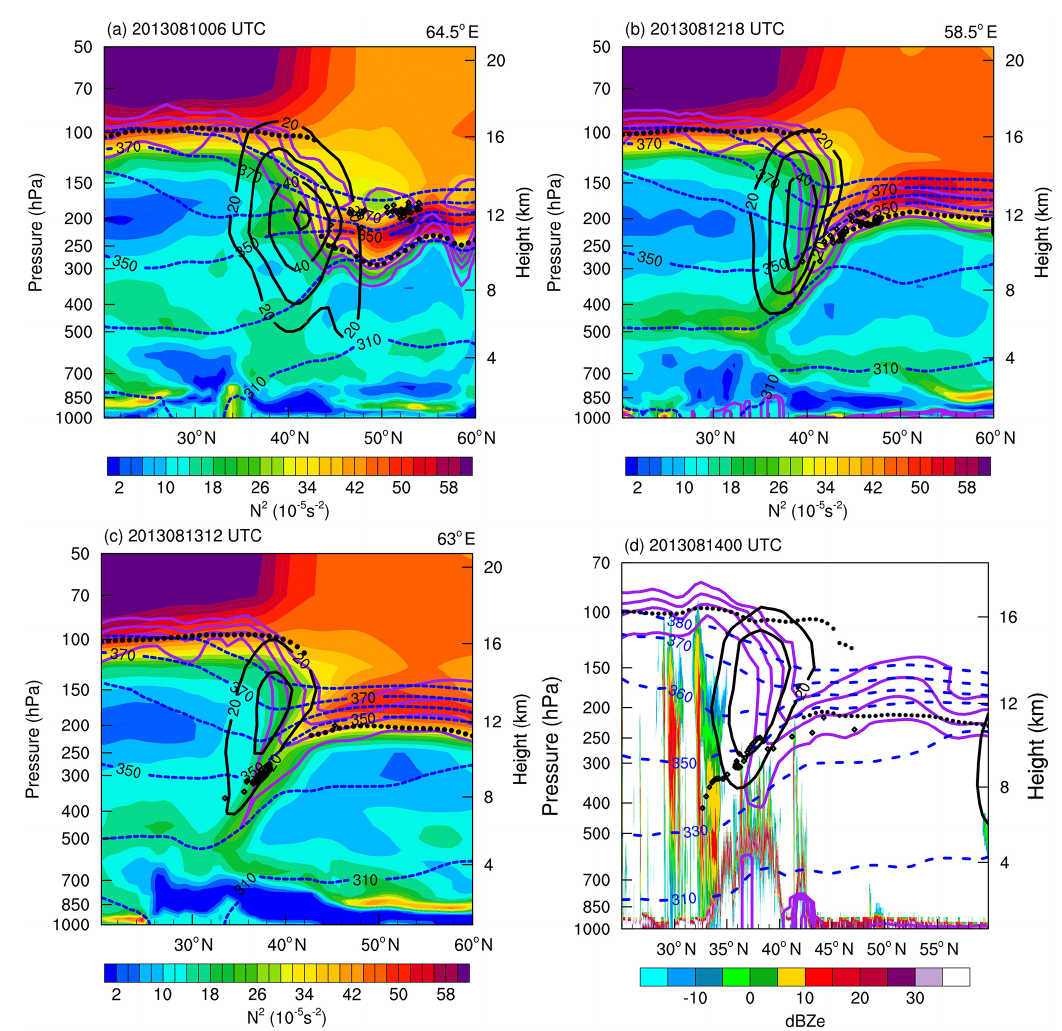
Figure 9. Latitude–pressure cross section of the square of the Brunt–Väisälä frequency ( N 2 ) along the average longitude of the bottom air parcels in Fig. 5b on (a) 10 August, 06:00UTC; (b) 12 August, 18:00UTC; and (c) 13 August, 12:00UTC, with potential temperature (blue dashed lines, K), PV (purple lines, PVU), tropopause (black dots, hPa), zonal wind (black lines) from ERA-Interim, and air parcels (diamonds) from the CLaMS trajectory model. (d) The same as panel (a) except for radar reflectivity (dBZe) but on 14 August, 00:00UTC, from